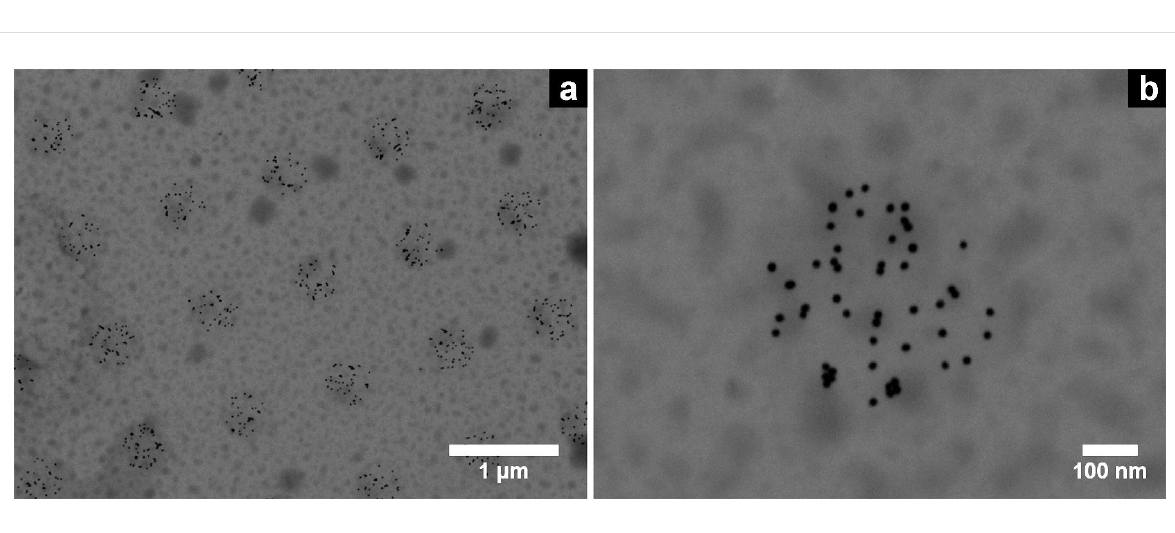
Figure 2: SEM pictures of irradiated CSPETCS layer on a Si/SiO 2 substrate (100 μ m/40 nm) after incubation with a solution of 16 nm AuNPs. Two patterns with circular structures of different intended diameter were used: 400 nm (a,b) and 200 nm (c,d).